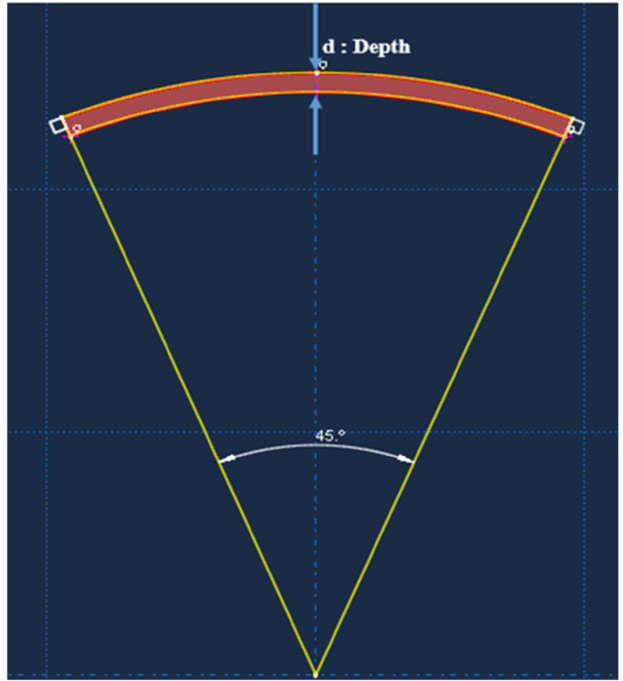
Figure 8. Assumed crack geometry for the simulation